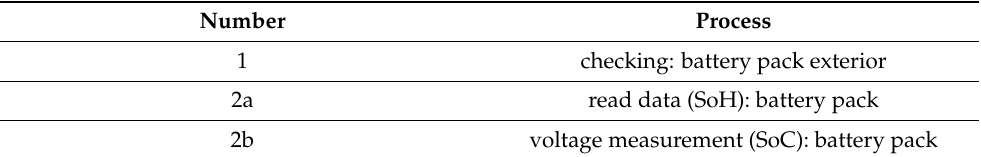
Table A5. Activities of the main processes “classification” and “disassembly”: status report.